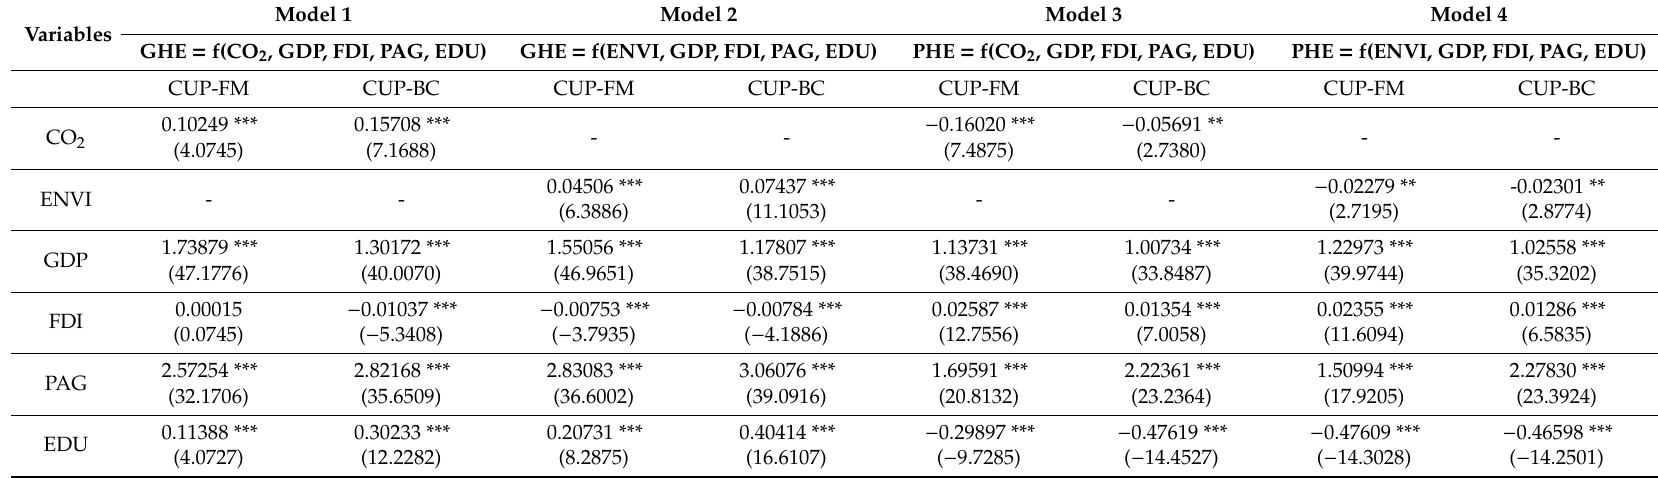
Table 6. Panel Long Run